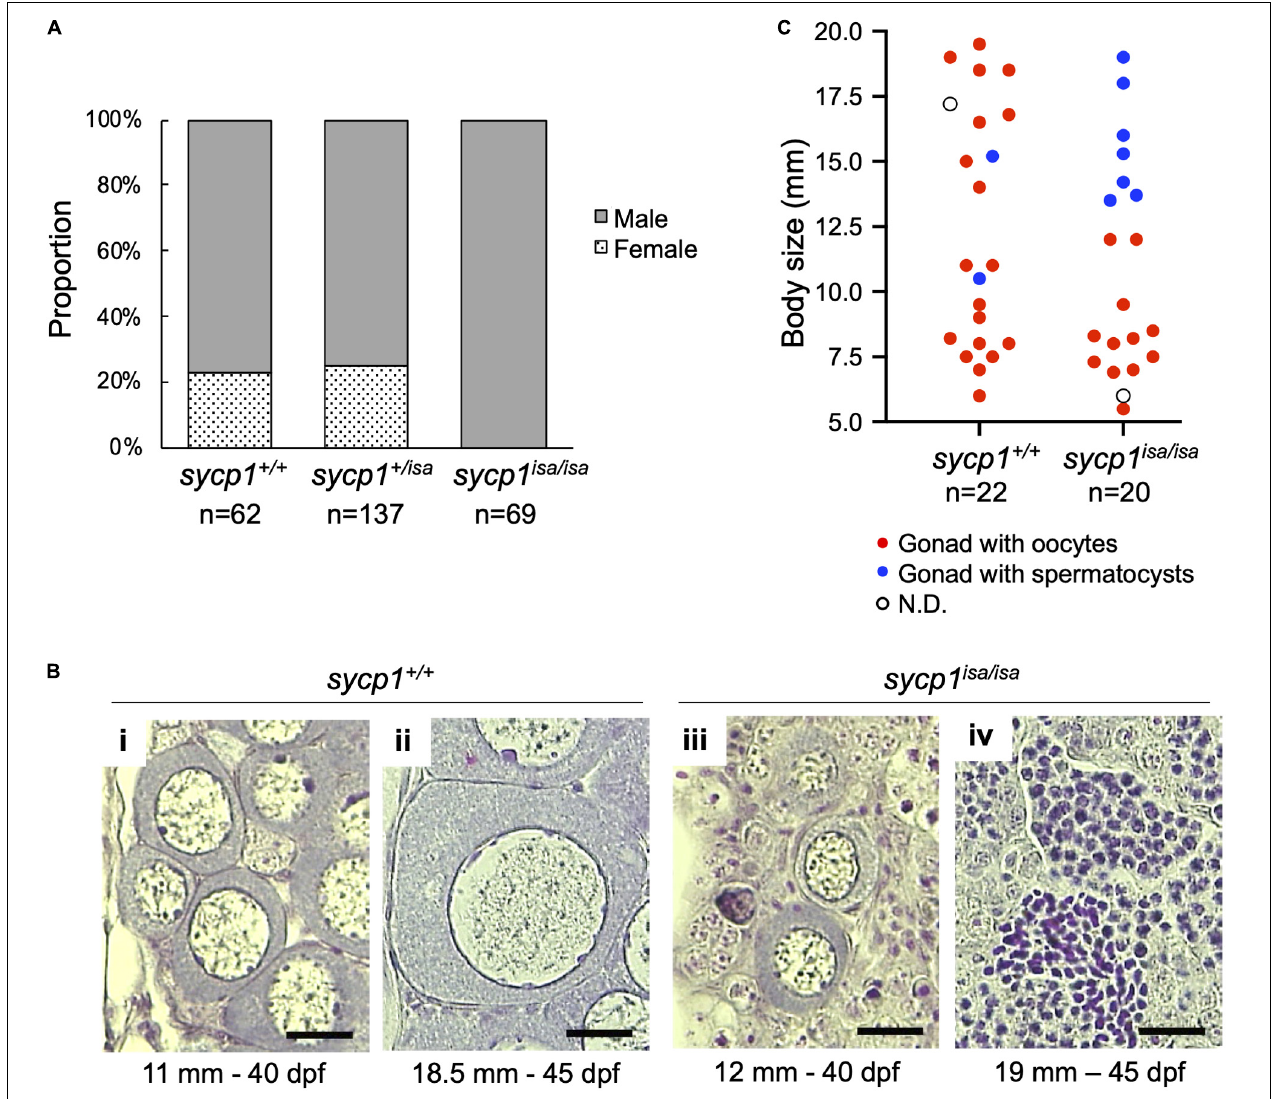
FIGURE 2 | Sexual phenotypes of sycp1 mutant zebrafish. (A) Sexual phenotypes of offspring from sycp1 + / isa incrosses. Proportions of offspring with testes (males) and ovaries (females) are shown for each genotype. The results of two incross matings were pooled and shown. (B) HE-stained sections of juvenile sycp1 + / + and sycp1 isa / isa gonads. Representative images of sycp1 + / + (i and ii) and sycp1 isa / isa (iii and iv) gonads with primary oocytes (i to iii) or spermatocysts (iv) are shown. Their body size (mm) and age (dpf: days post fertilization) are indicated below. Scale bars: 20 µ m. (C) Phenotypes of juvenile sycp1 + / + and sycp1 isa / isa gonads. Phenotypes of gonads from 24 to 45 dpf of sycp1 + / + and sycp1 isa / isa fish were examined by HE staining and categorized into gonads with oocytes (red dots), gonads with spermatocysts (blue dots) and N.D. (not determined: open circle) and were plotted by their body size. Pooled results of siblings from two crosses are shown. Representative images are shown in Figure 2B . Histological images of all analyzed samples are shown in Supplementary Figure 3